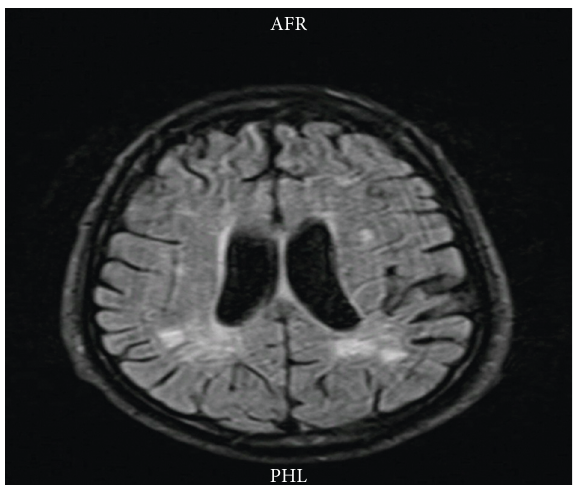
Figure 1: Brian MRI showing bilateral cerebral subcortical, deep white matter, and centrum semioval bright signal foci in T 2/ weighted